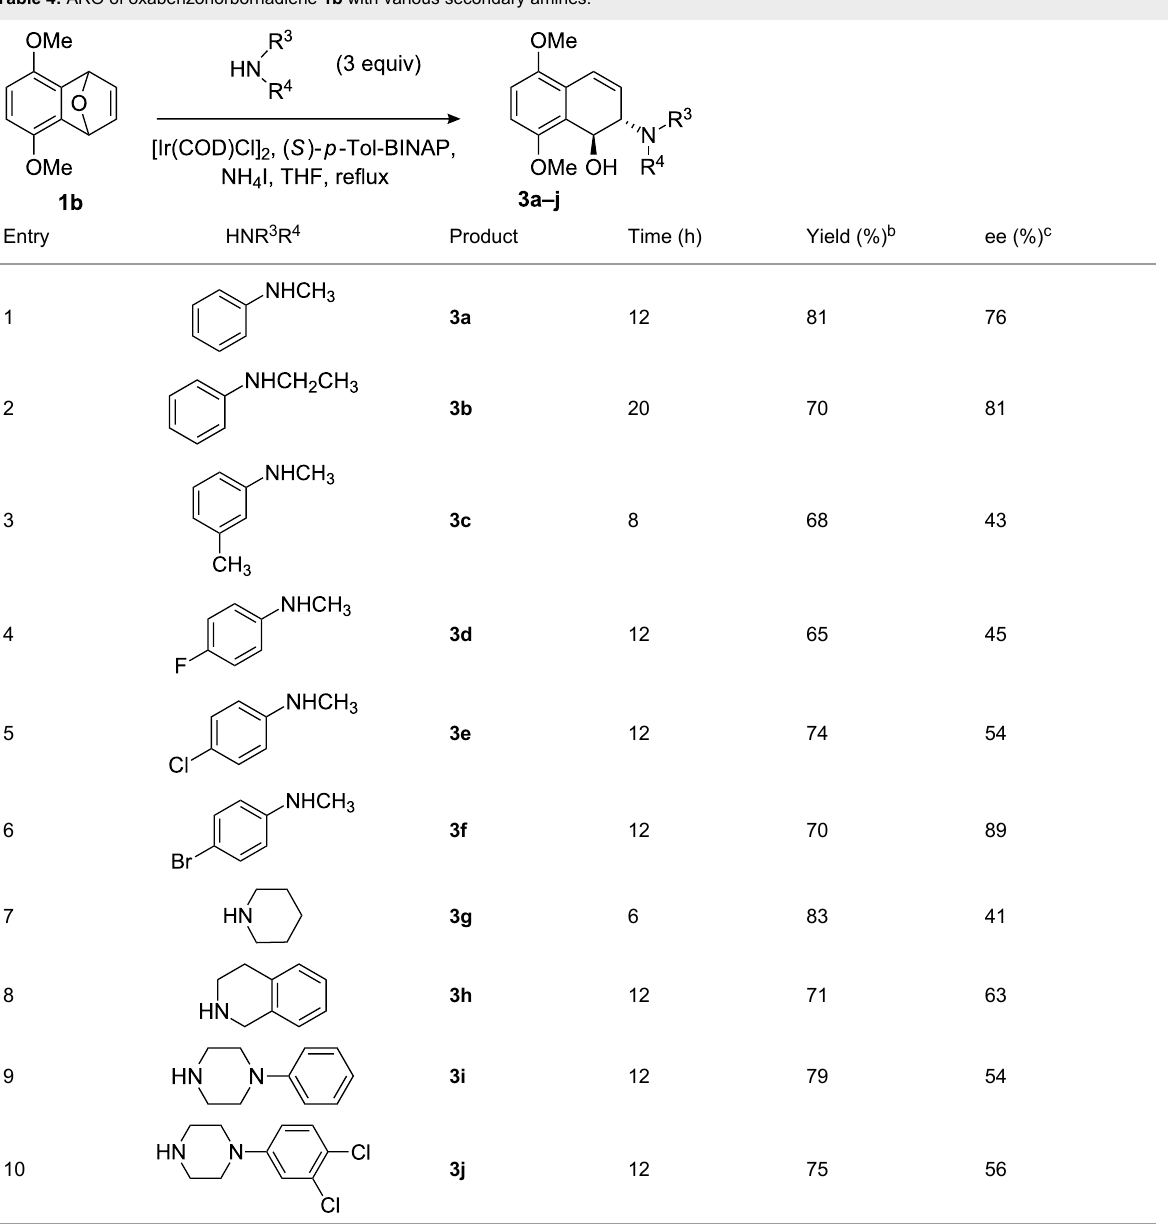
Table 4: ARO of oxabenzonorbornadiene 1b with various secondary amines.